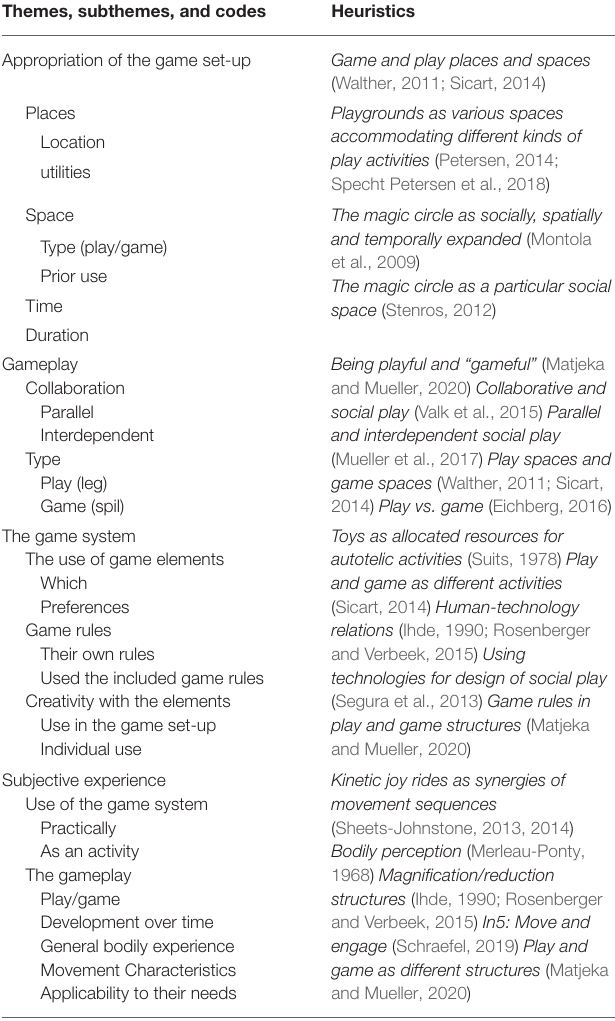
TABLE 1 | Themes, subthemes, and codes with corresponding heuristics. Themes, subthemes, and codes